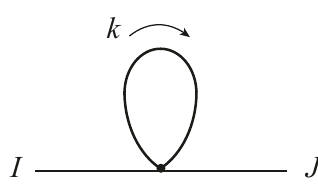
Figure 4 . The one-loop \tadpole"